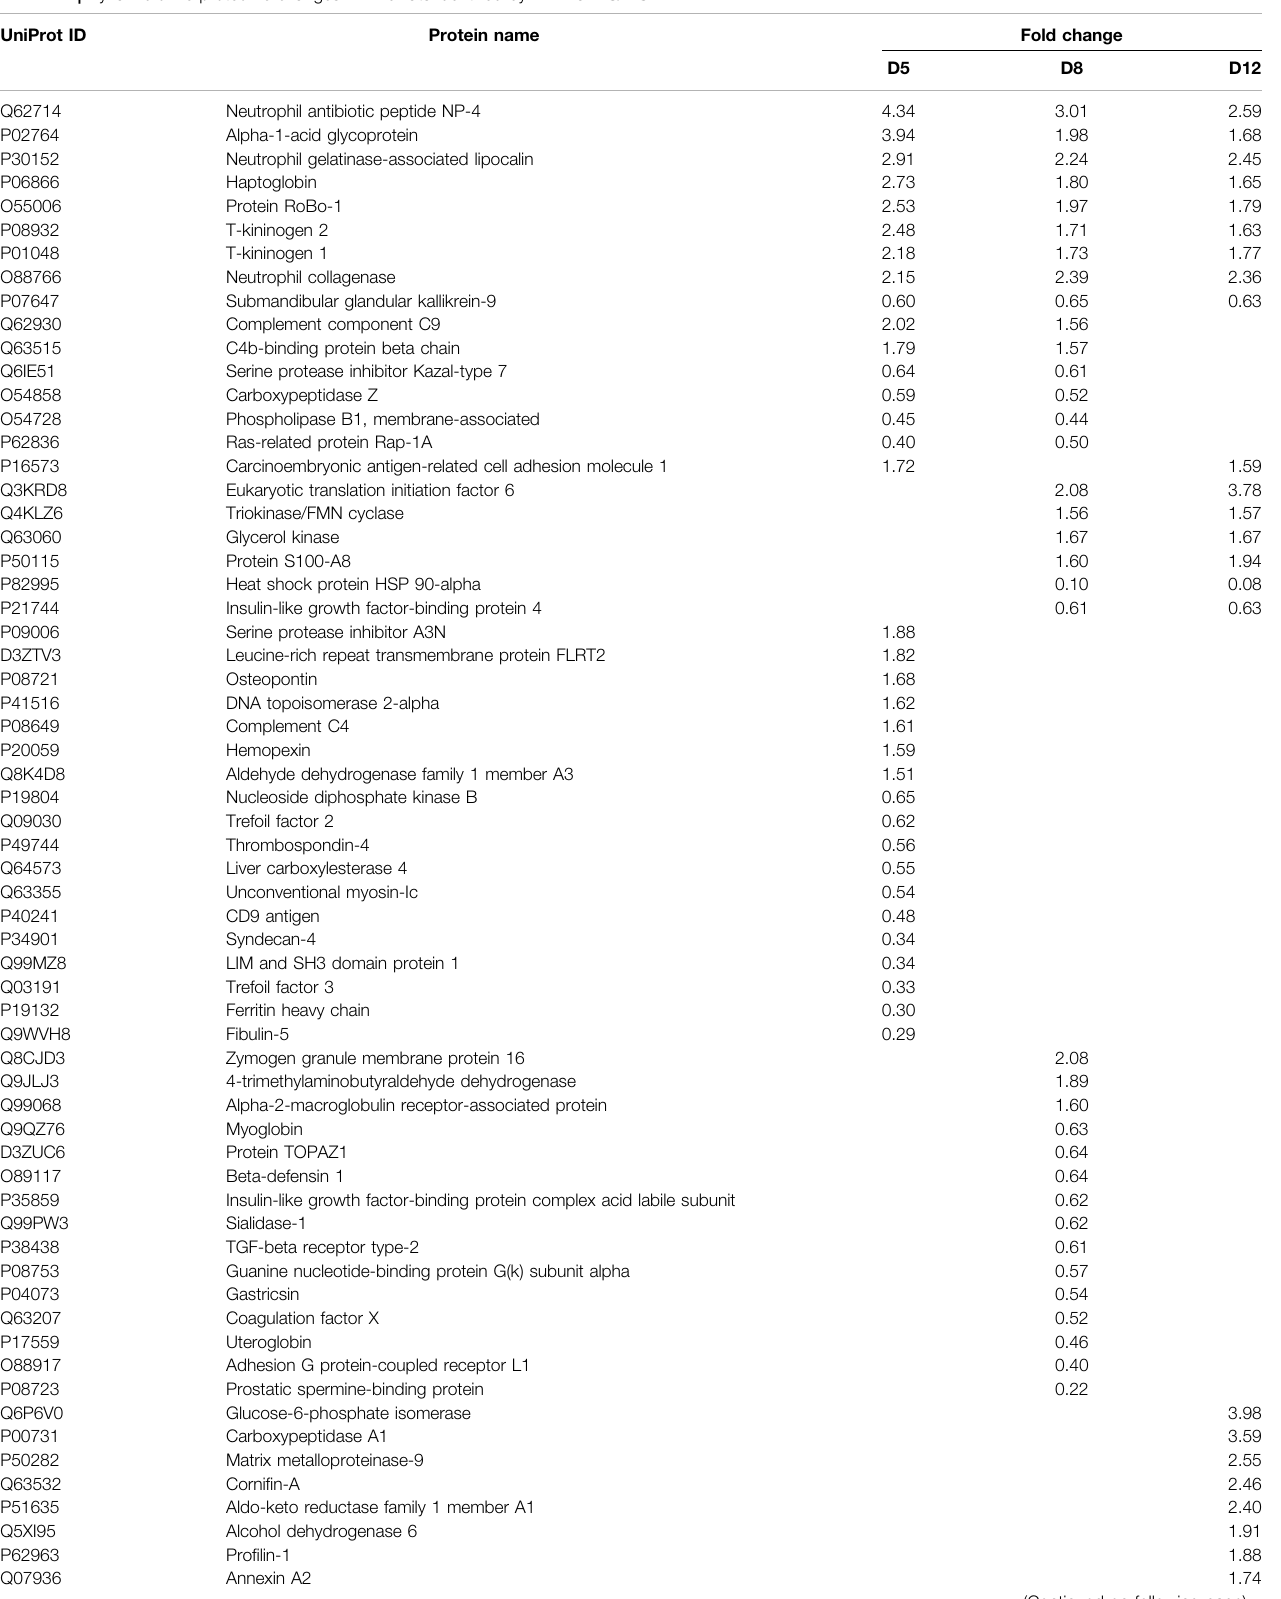
TABLE 1 | Dynamic urine proteome changes in EAU rats identi fi ed by DIA LC-MS/MS. UniProt